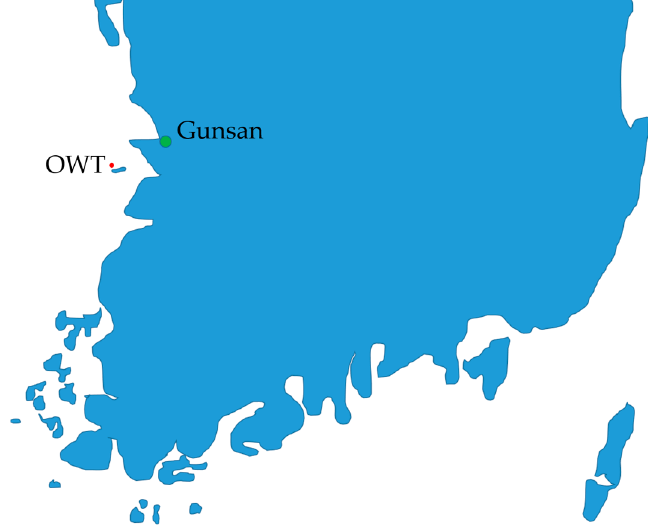
Figure 2. The geographic location of OWT in Korea.